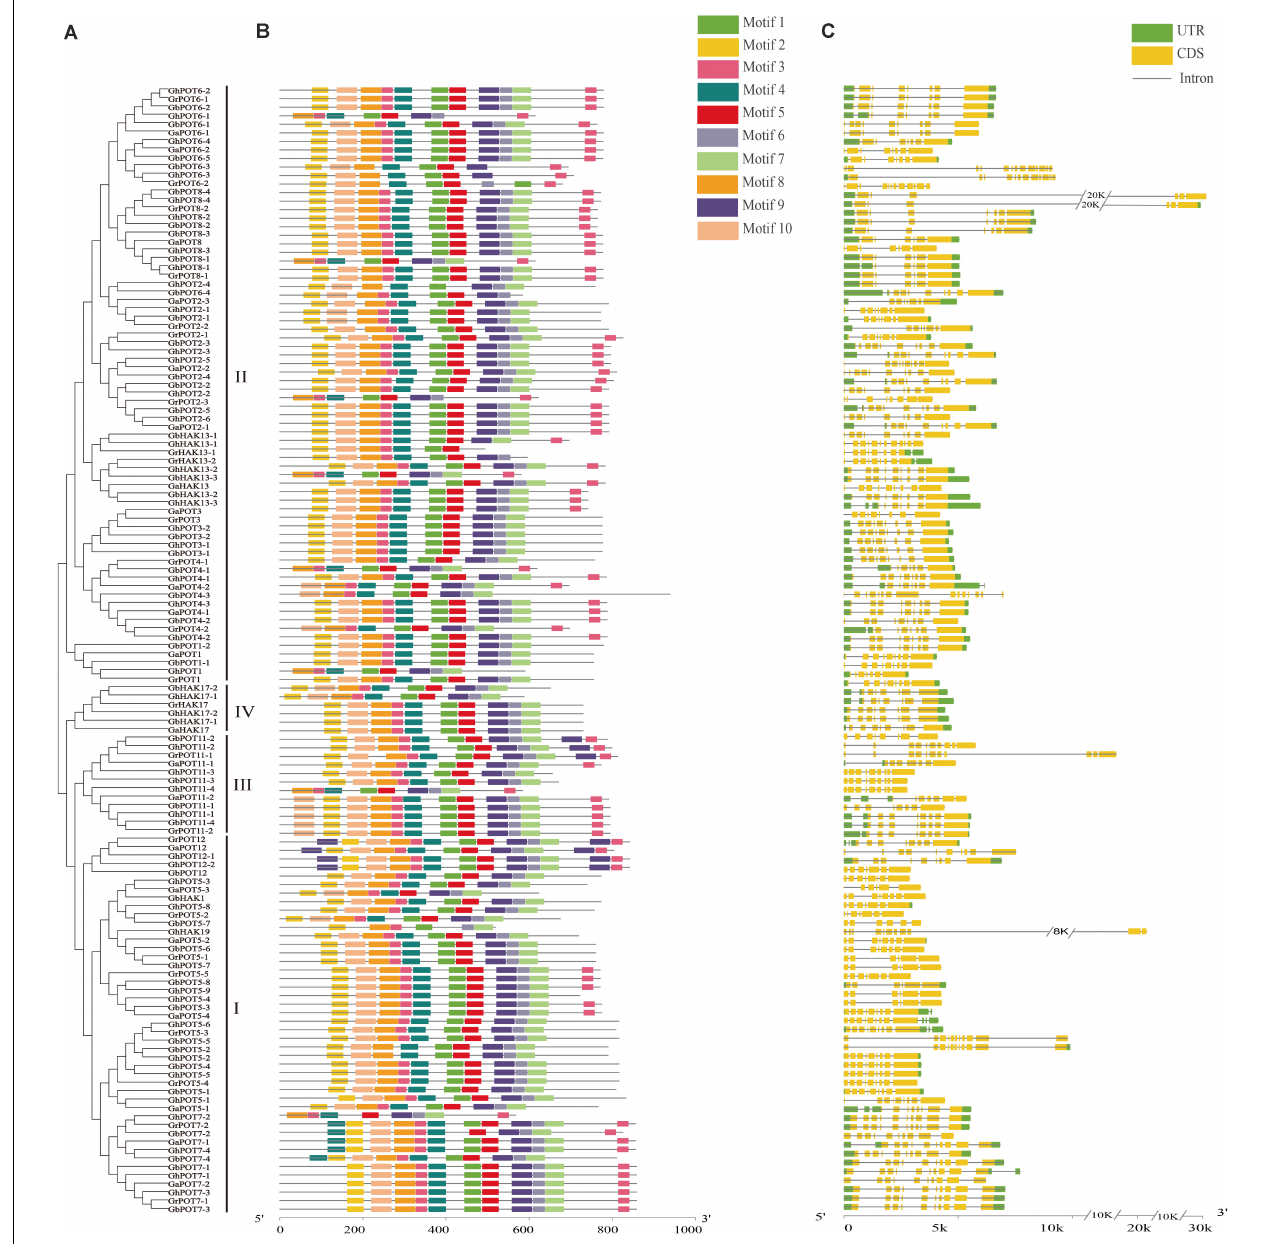
FIGURE 2 | Phylogenetic relationships, motif analysis and exon-intron structures of GrPOTs, GaPOTs, GhPOTs, and GbPOTs. (A) Phylogenetic analysis of 134 HAK/KUP/KT proteins using MEGA 6.0 by the neighbor-joining (NJ) method. I, II, III, and IV were the clusters determined by the phylogenetic analysis. (B) The 10 motifs of 134 HAK/KUP/KT proteins were determined by MEME. Differently colored boxes represent different motifs. (C) Exon–intron structures of 134 HAK/KUP/KT genes. UTRs (untranslated regions), exons, and introns are indicated by green boxes, yellow boxes, and black lines,